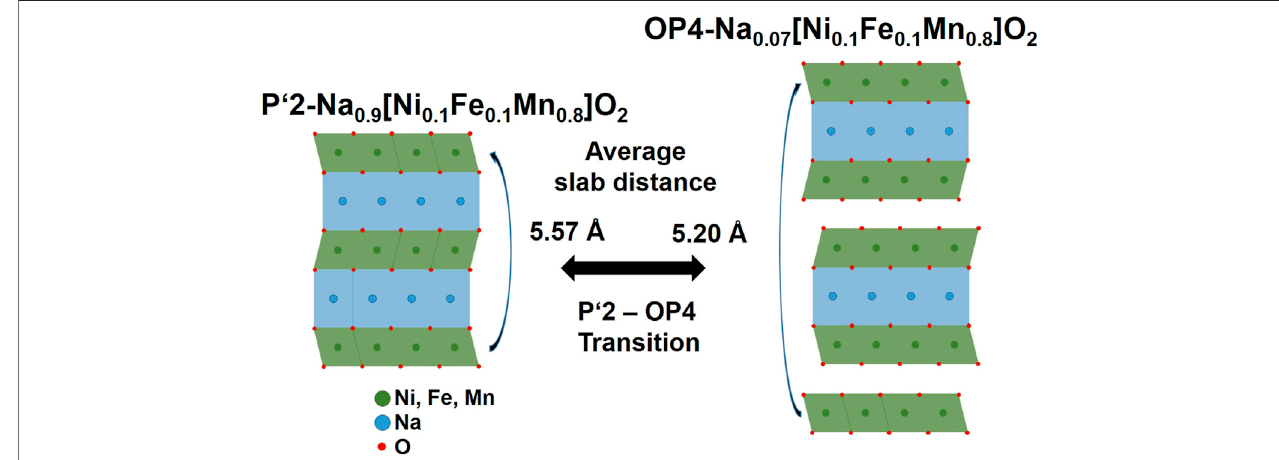
FIGURE 1 | Structural transition of NNFM from sodiated to de-sodiated state.